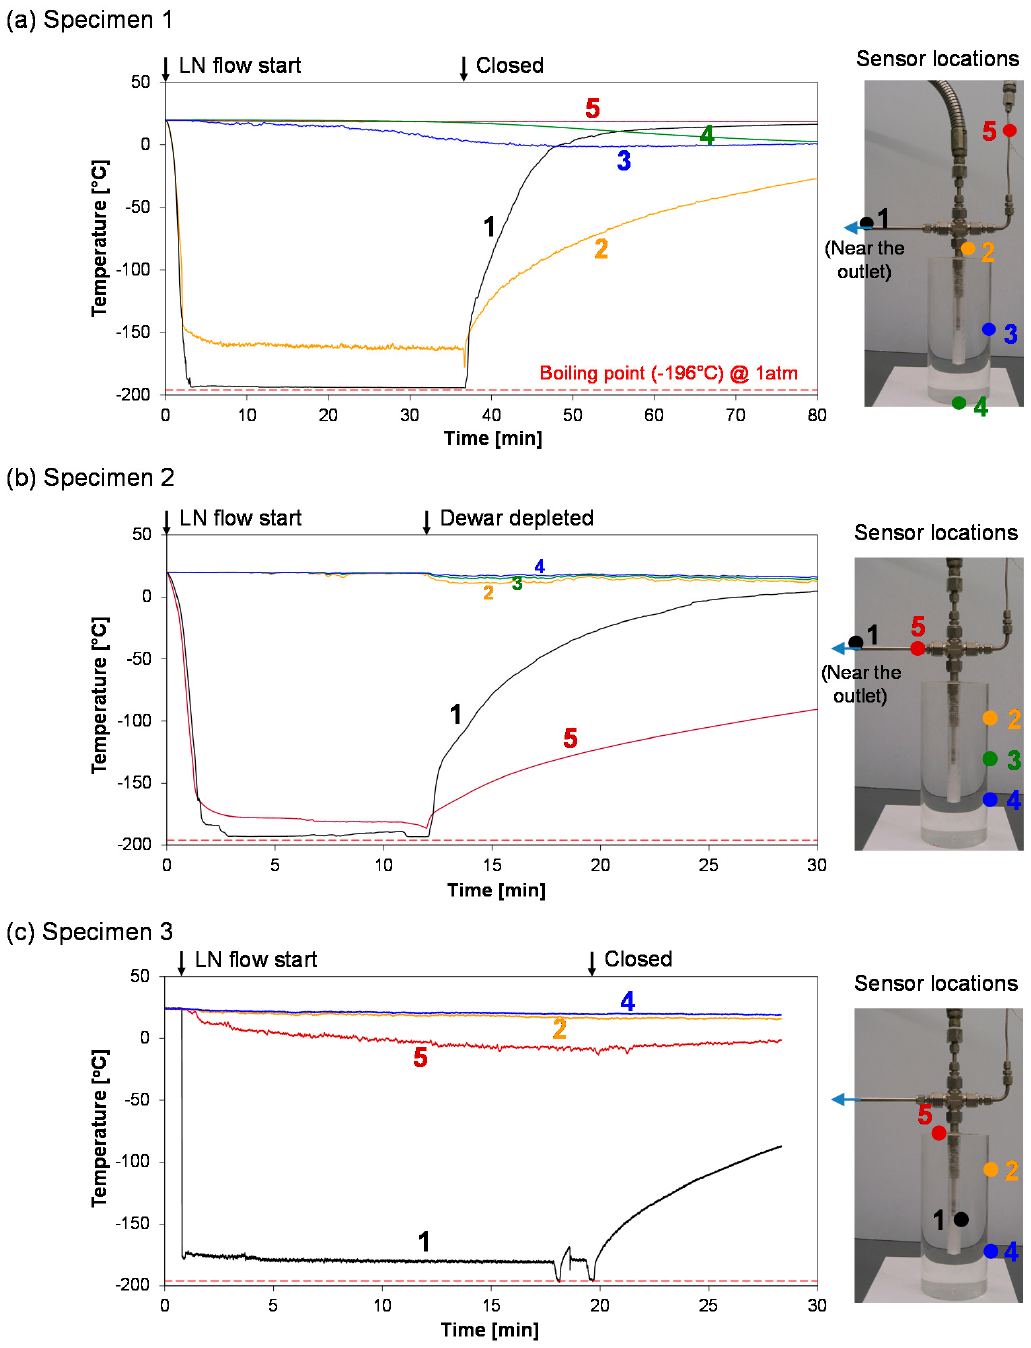
Figure 3. Locations of temperature sensors and temperature changes during the liquid nitrogen thermal shock experiments.